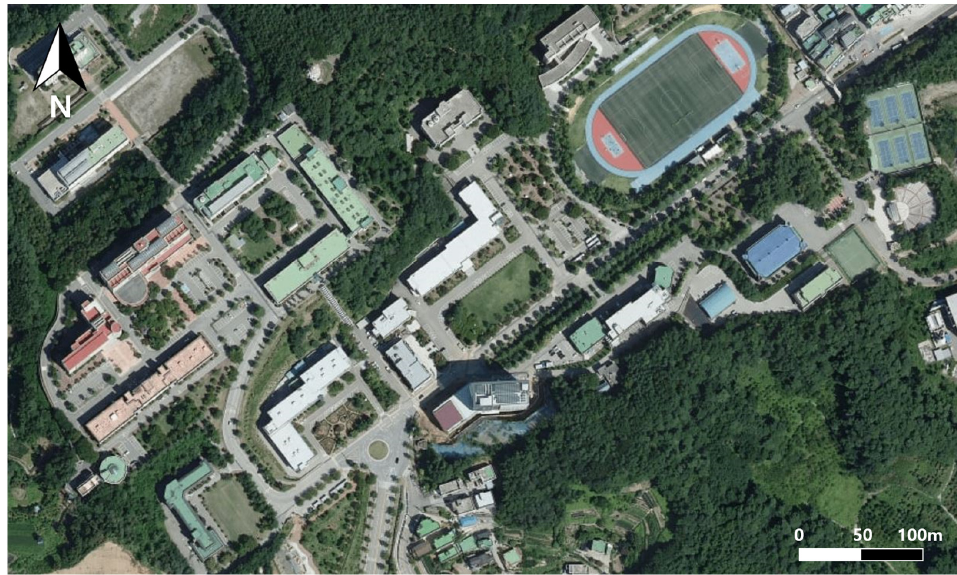
Figure 1. Satellite image of Kangwon National University Samcheok Campus.